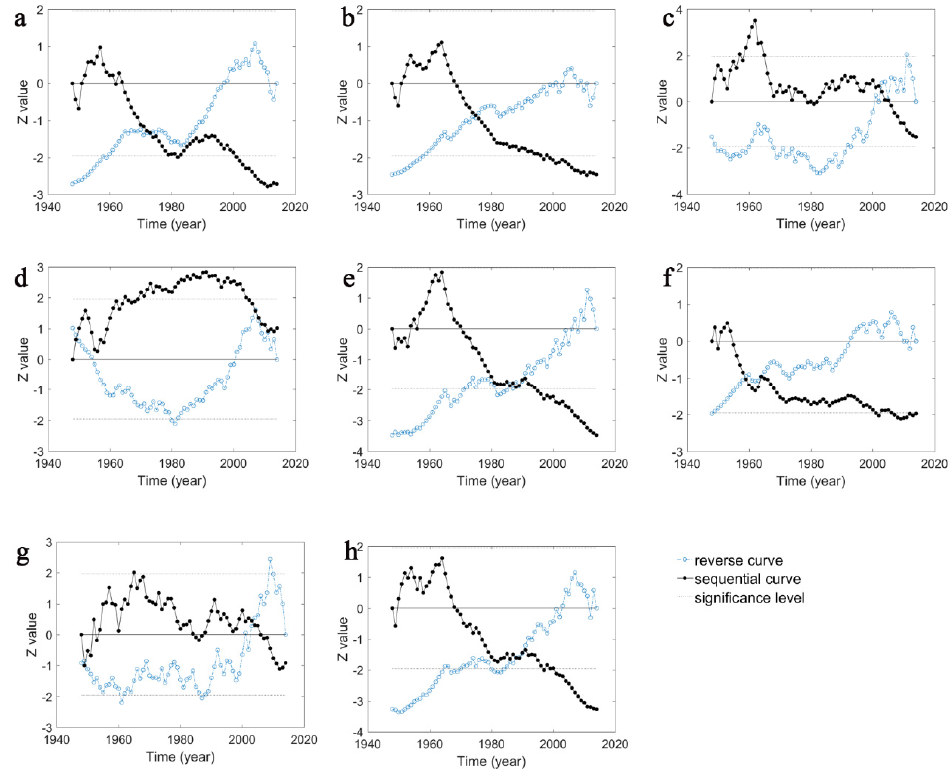
Figure 5. Mann-Kendall test results of soil moisture variation from 1948 to 2014; ( a ) NEC; ( b ) NC; ( c )